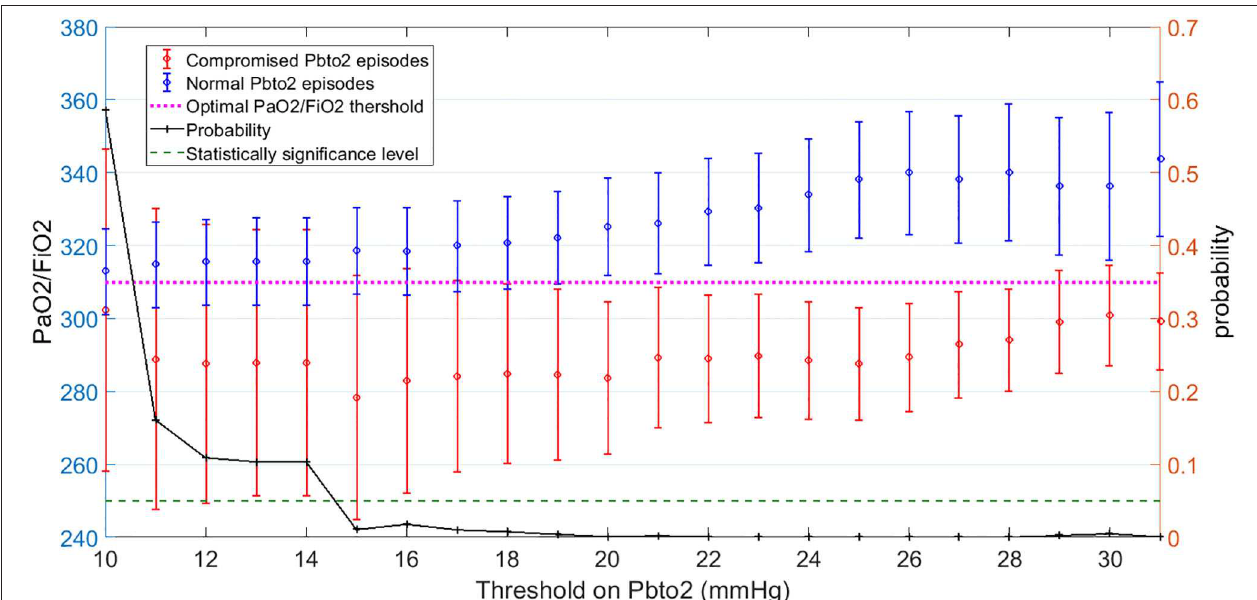
FIGURE 3 | Left-side vertical axis shows the average and 95% Confidence Interval (CI) of PaO2/FiO2 values for two groups of episodes: Those with compromised PbtO2 values of PbtO2 < Threshold (in red) and those with normal PbtO2 values of PbtO2 ≥ Threshold (in blue). Right-side vertical axis indicates the probability of the t -test that the average of PaO2/FiO2 values are significantly different between the normal (blue) and compromised episodes (red). The vertical axis displays the Threshold values on PbtO2. The dashed green line represents the probability significance level of 0.05. So, whenever probability of the t -test (in black) is below the dashed green line, PaO2/FiO2 values are significantly different between those episodes with compromised and normal PbtO2 values: This happened when PbtO2 Threshold is within the range of 20–30 mmHg. The average value of PaO2/FiO2 for when PbtO2 Threshold is within the range of 20–30 corresponds to 310 (The dashed pink line). Thus, PaO2/FiO2 = 310 can be employed as the optimal threshold value on PaO2/FiO2 to define a hypoxic episode.